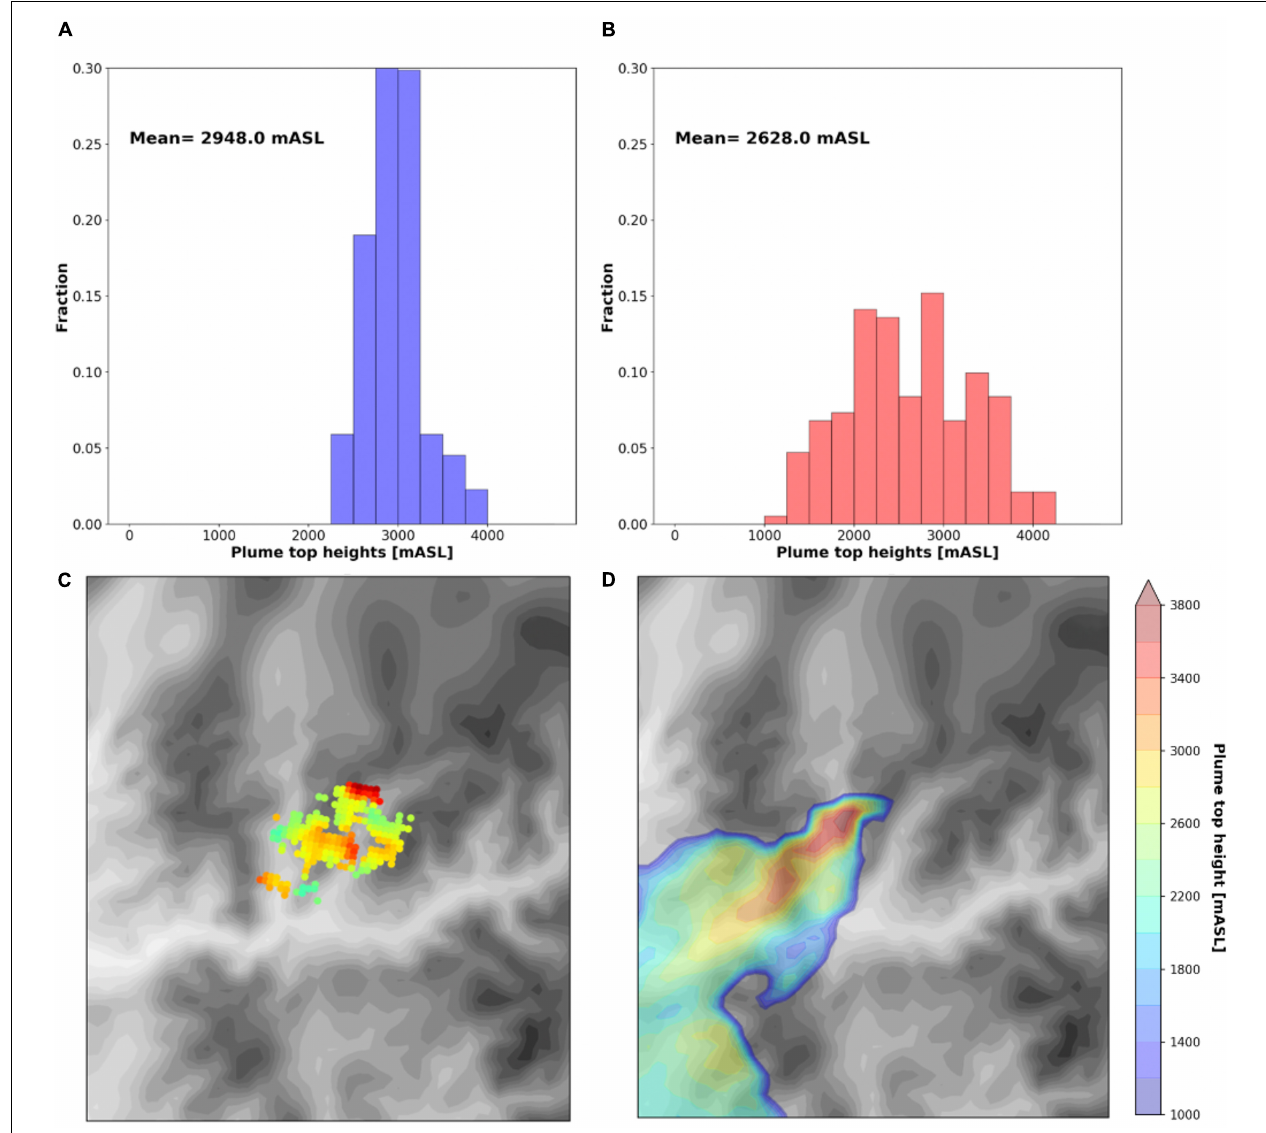
FIGURE 6 | MISR-derived (A,C) vs. modeled (B,D) plume top heights for the Pioneer fire on August 24, 2016 at 18:50 UTC. (A,B) Histograms of plume top heights near the center of the fire plume. (C,D) Spatial maps of the plume top heights. The gray shaded contours represent terrain heights where black corresponds to higher terrain heights, while the lighter gray shading represents lower terrain